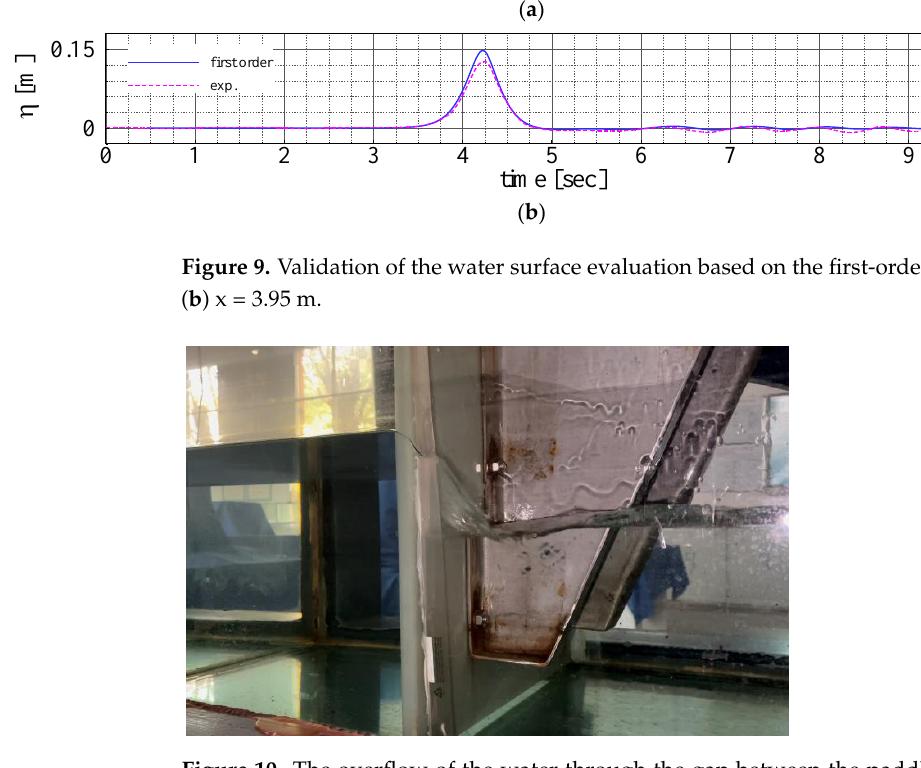
Figure 10. The overflow of the water through the gap between the paddle and a side wall of the wave flume.